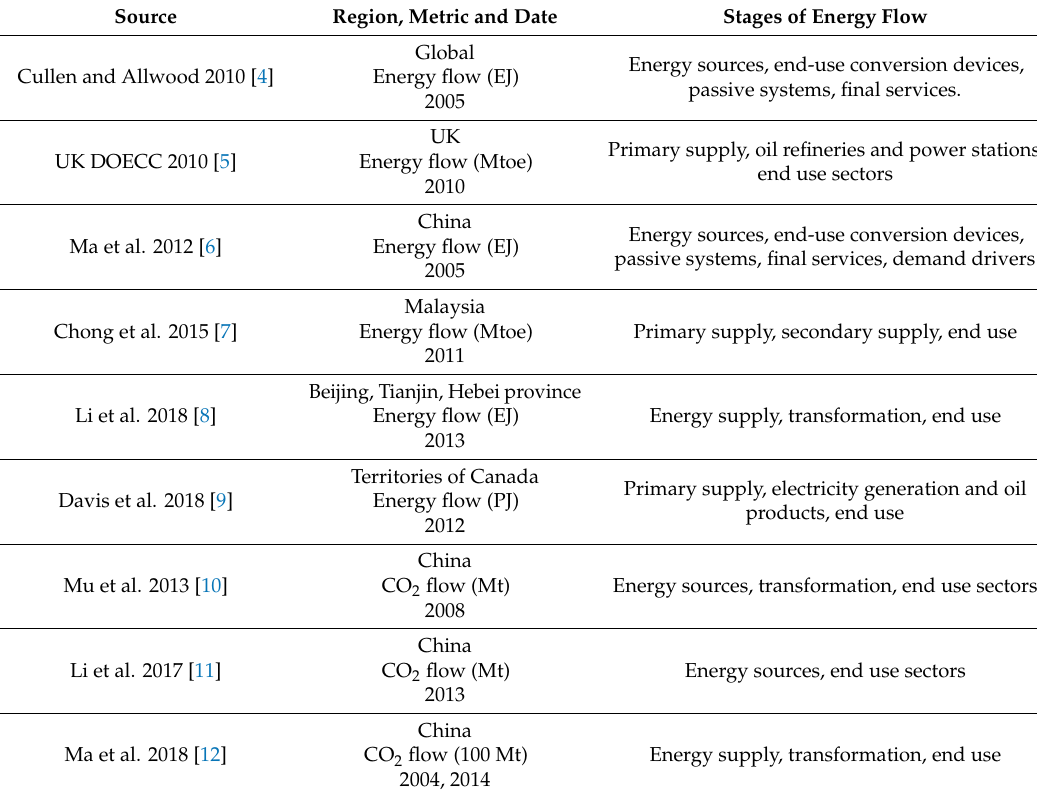
Table 1. Studies applying Sankey diagrams to energy system